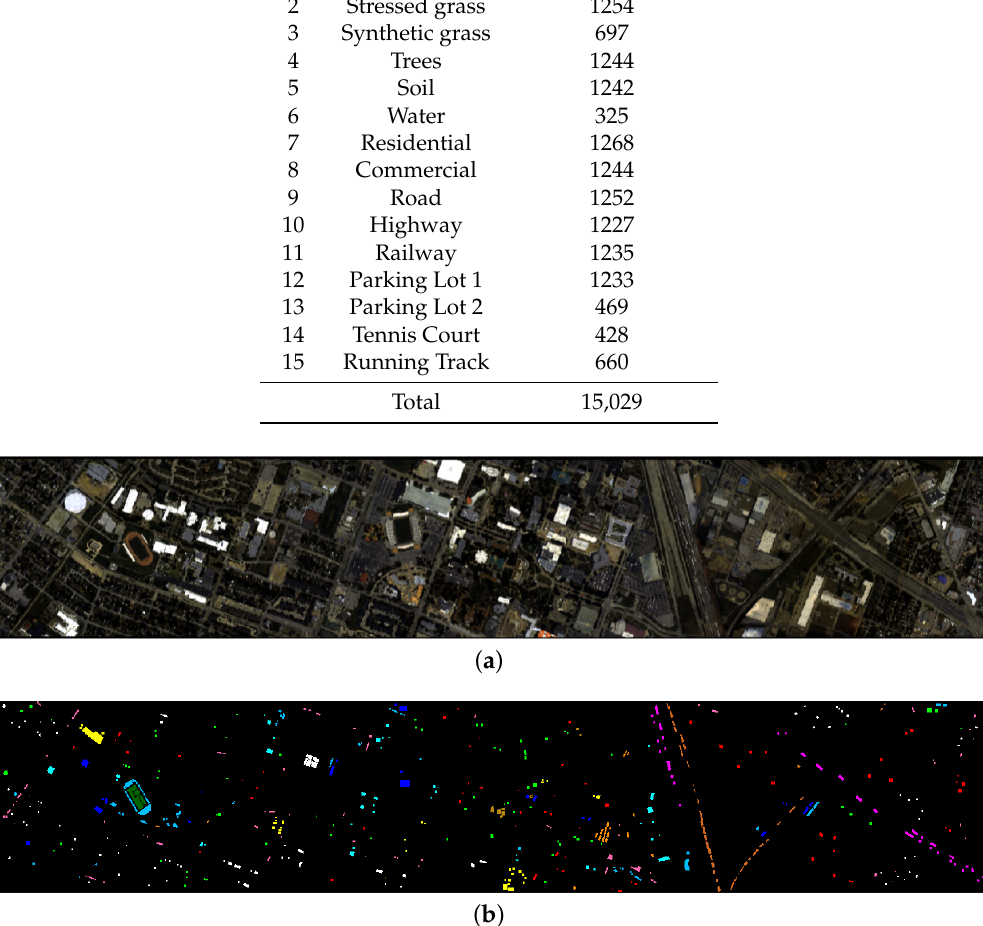
Figure 2. The False color images ( a ) and the corresponding ground truth classification ( b ) of the data set GRSS2013